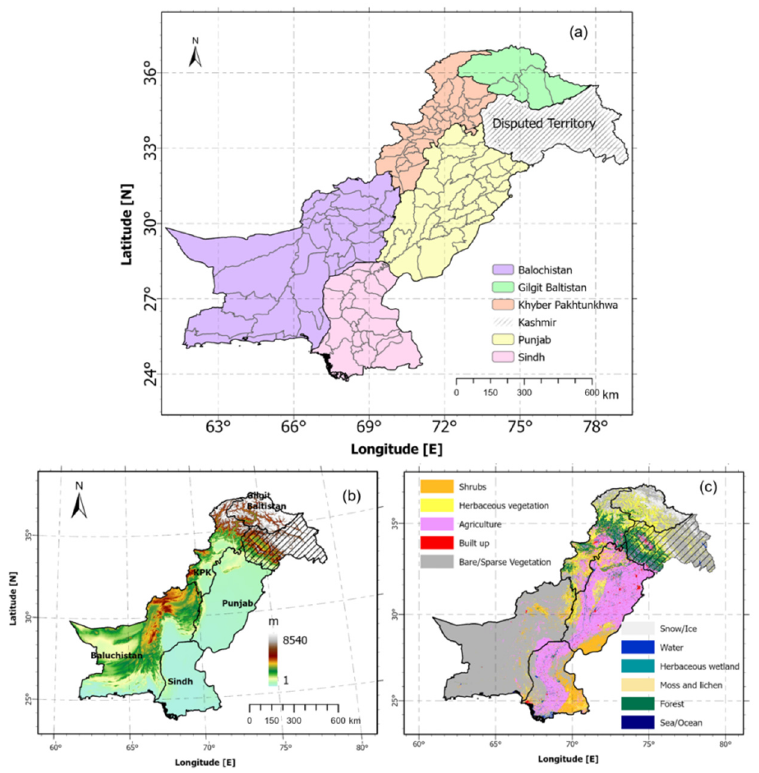
Figure 1. ( a ) District and administrative unit boundaries, ( b ) topography and ( c ) landcover map of Pakistan. The shaded area shows the disputed territory of Kashmir.